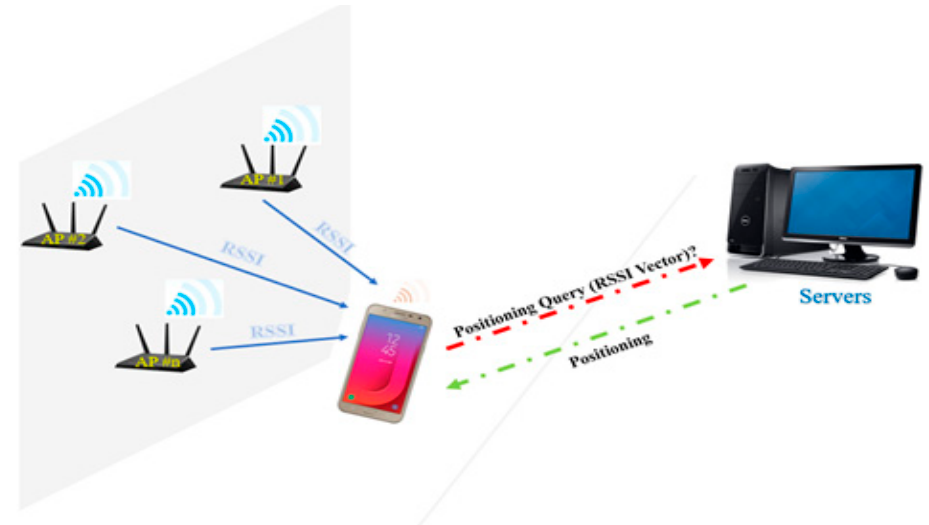
Figure 3. The proposed fingerprint-based Wi-Fi positioning system.